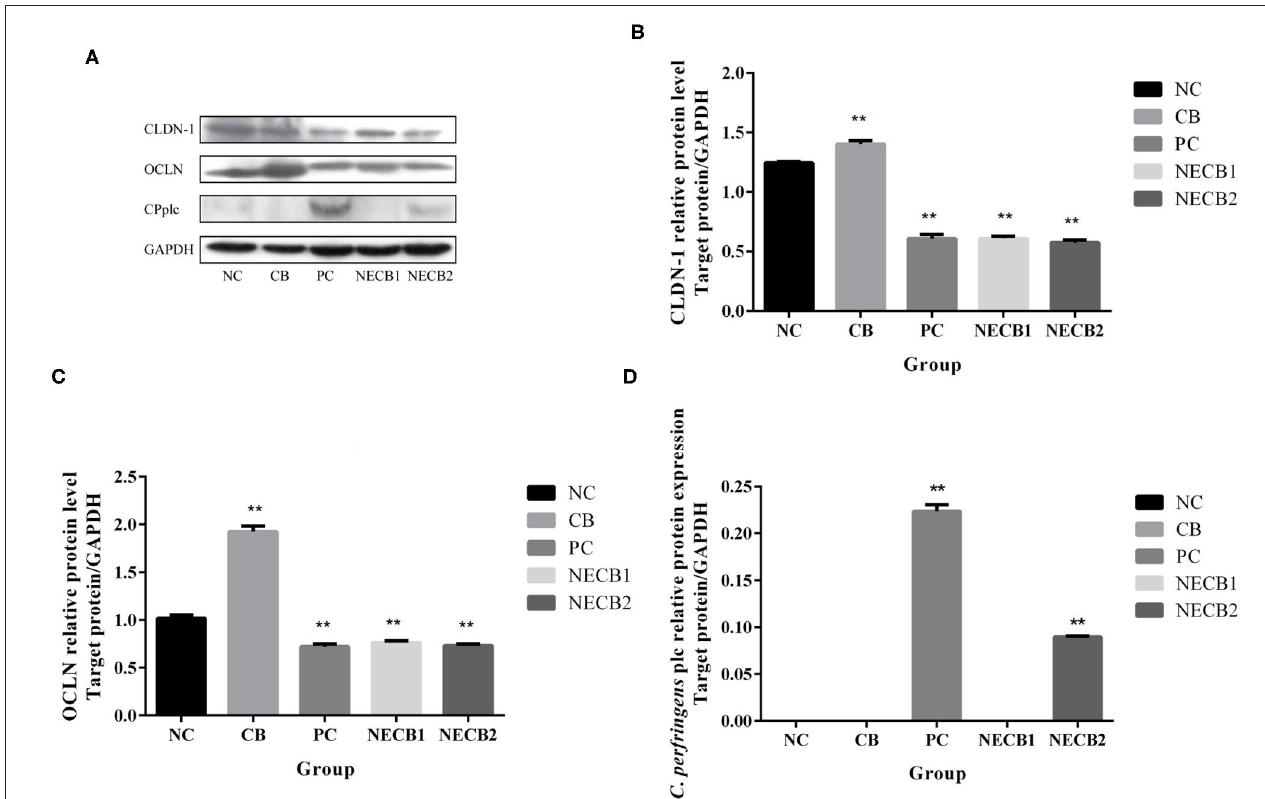
FIGURE 5 | Protein expression in the small intestine. (A) Western blot analysis results of GAPDH, CLND-1, OCLN, CPplc. (B) CLDN-1. (C) OCLN. (D) CPplc. Each result represents the mean ± SEM ( n = 3). **Represent p <